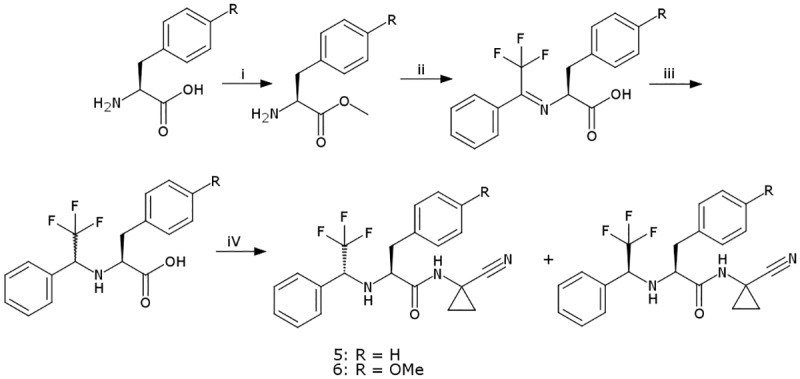
Synthesis of compounds 5 and 6.Reagents and conditions: (i) SOCl2, MeOH, r.t., 2.5 h, reflux 30 min, r.t. 4 h, 88%; (ii) PhC (= O)CF3, K2CO3, MeOH, 50°C, 18 h, R = H 66%, R = OCH3 58%; (iii) THF, NaBH4, R = H 67%, R = OCH3 56%; (iv) HATU, 1-amino-1-cyclopropanecarbonitrile, DIPEA, DMF, r.t., 24 h, R = H 92%, R = OCH3 90%.